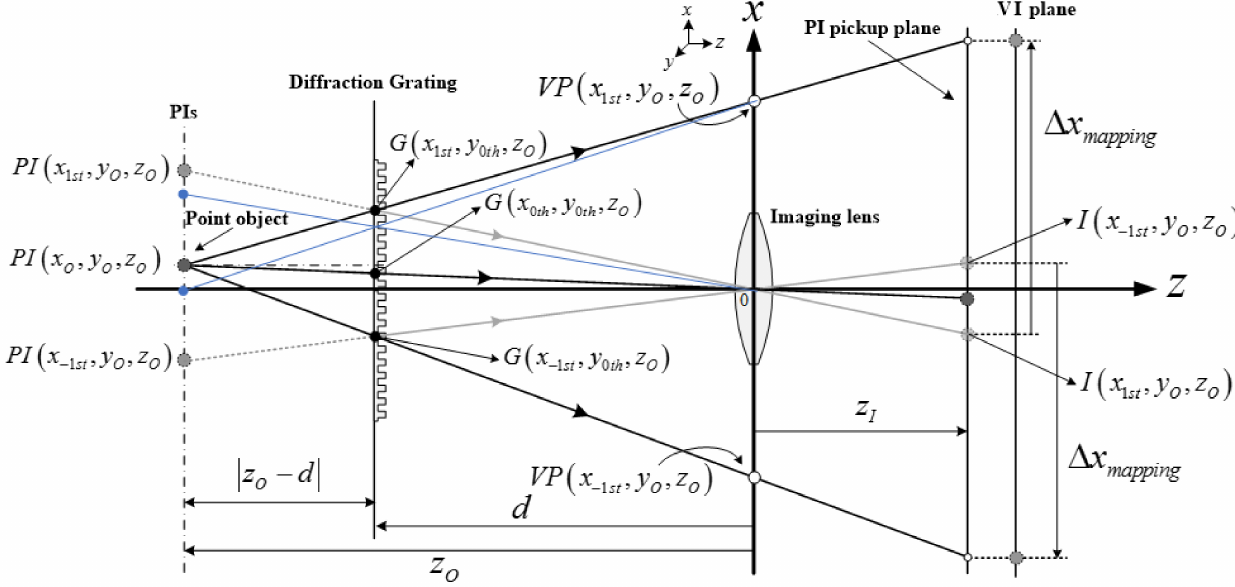
Figure 6. Geometries for virtual pinhole model among a point object, virtual pinholes (VP), virtual image (VI) plane, and I ( x 1st , y O ,z O ). For more details see